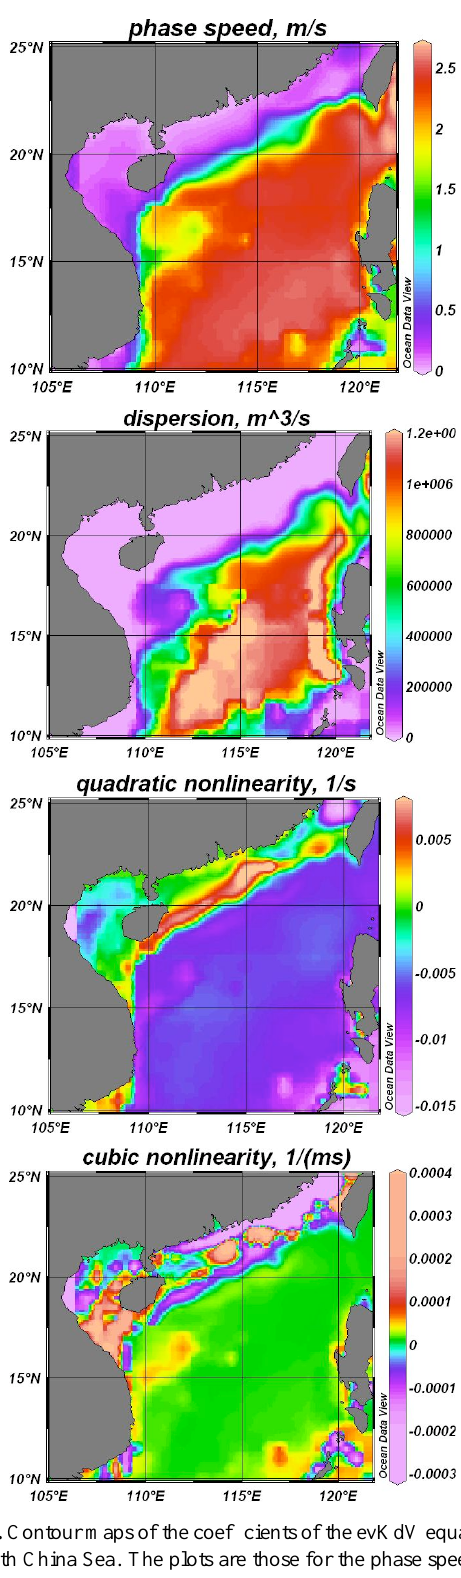
Fig. 11. Contour maps of the coefficients of the evKdV equation for the South China Sea. The plots are those for the phase speed c , the dispersion coefficient δ , the quadratic coefficient µ , and the cubic coefficient µ 1 .